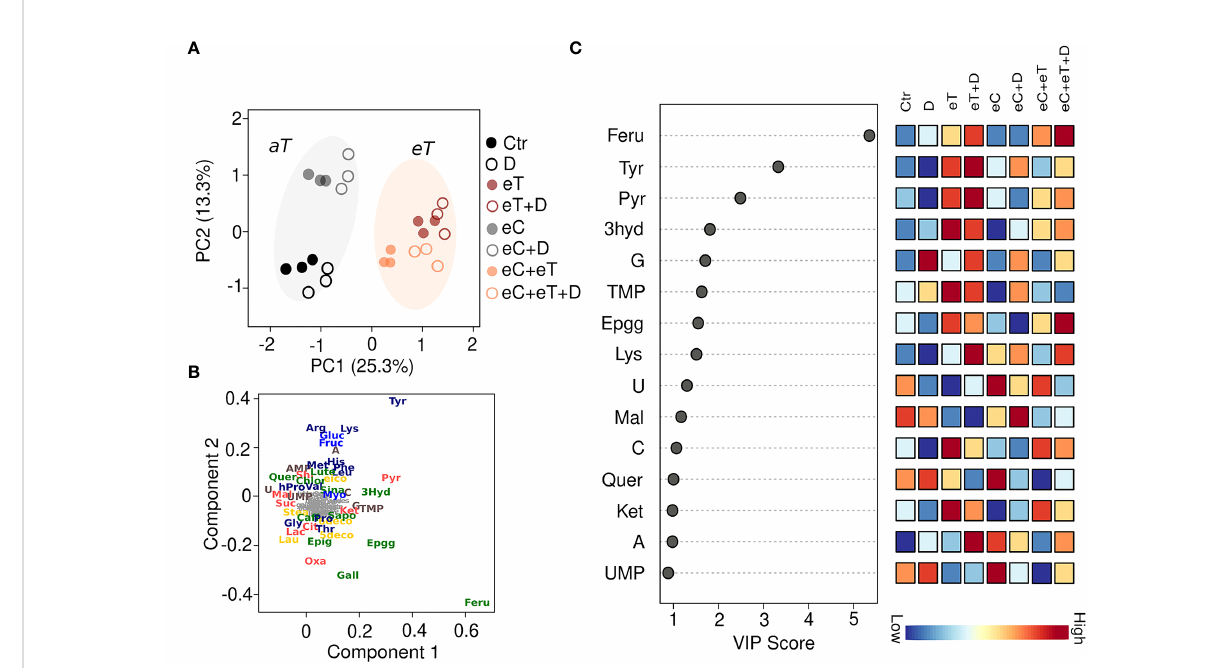
FIGURE 3 A supervised Partial Least Squares Discriminant Analysis (PLS-DA) of all the metabolites accumulated in the leaves of wheat cv. Cadenza after exposure to climate regimes. (A) Scores plot showing the distribution of metabolites based on the regimes. PC1 separated the metabolites based on the ambient ( aT , gray circle) and elevated temperature ( eT , orange circle). (B) Loading plot showing the metabolites discriminated based on PLS-DA. The metabolites such as phenolics (green), amino acids (dark blue), Krebs cycle intermediates (red), lipids (yellow) and nitrogenous bases (brown) have been shown. (C) The metabolites ranked by variable importance in projection (VIP). Ctr, control treatment; eC, elevated CO 2 ; eT, elevated temperature; D, drought; eC+eT, elevated CO 2 and elevated temperature; eC+ D, elevated CO 2 and drought; eT+D, elevated temperature and drought; eC+eT+D, elevated CO 2 , elevated temperature and drought. The color code represents the speci fi c metabolite families: dark blue, amino acid; light blue, saccharides; green, phenolics; yellow, fatty acids; red, Kreb ’ s cycle acids; brown, nucleotides. Compounds in grey represent non-signi fi cant ( P ≤ 0.05) metabolites among the treatments identi fi ed by one-way ANOVA. Three biological replicates ( n =3) per treatment were used in the